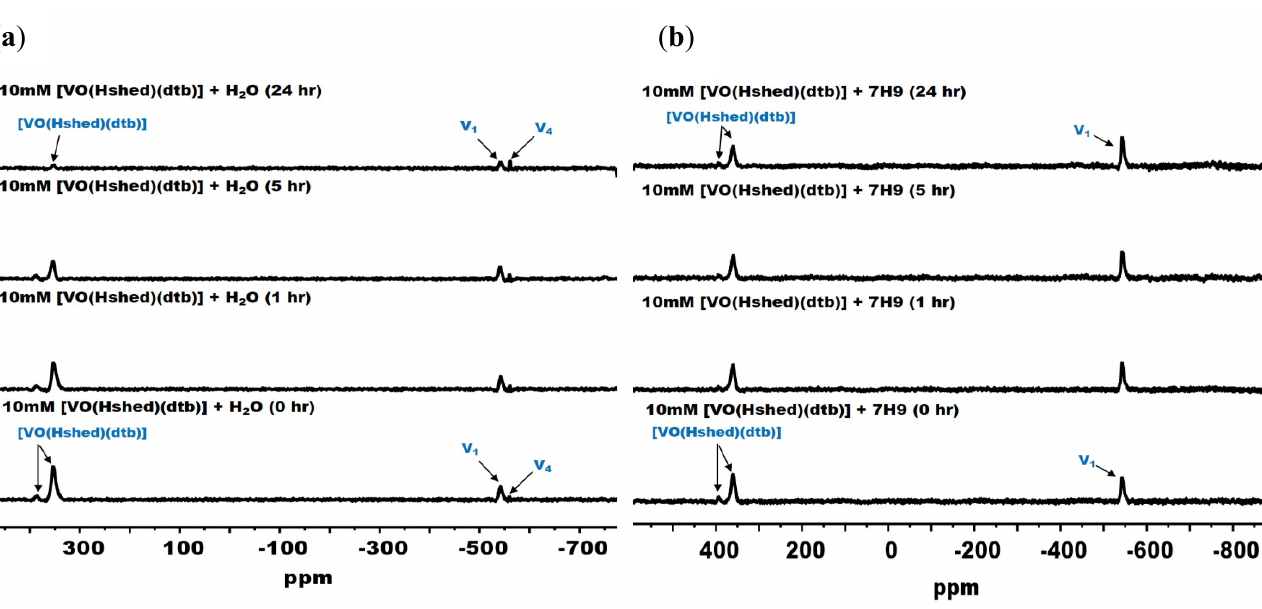
Figure 5. The 51 V NMR spectra of 10 mM [VO(Hshed)(dtb)] at 0, 1, 5, and 24 h time points in ( a ) 50:50 H 2 O:DMSO and in ( b ) 50:50 7H9 growth medium: DMSO. The spectra of [VO(Hshed)(dtb)] at time=0 (t = 0) showed two peak signals assigned to [VO(Hshed)(dtb)] at δ = 387 and 353 ppm, in addition to the presence of the other two sig- nals assigned to V 1 at δ = − 541 ppm and vanadate tetramer (V 4 O 124- ) V 4 at δ = − 557 ppm. The percentage of each species measured at the initial time point is summarized in Table 4. Table 4. Species observed for 10 mM Schiff base vanadium-catecholate complexes in the mixture